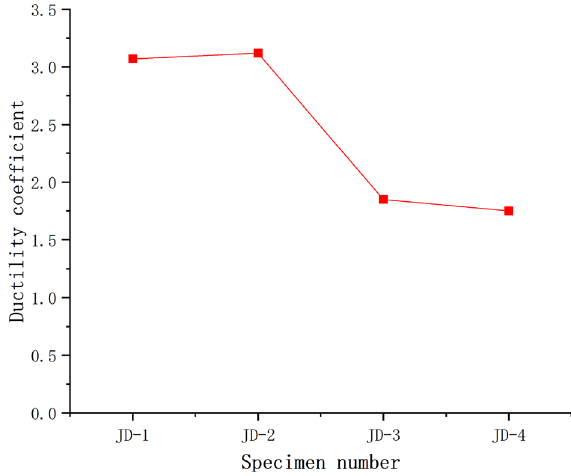
Figure 9. Ductility factor of